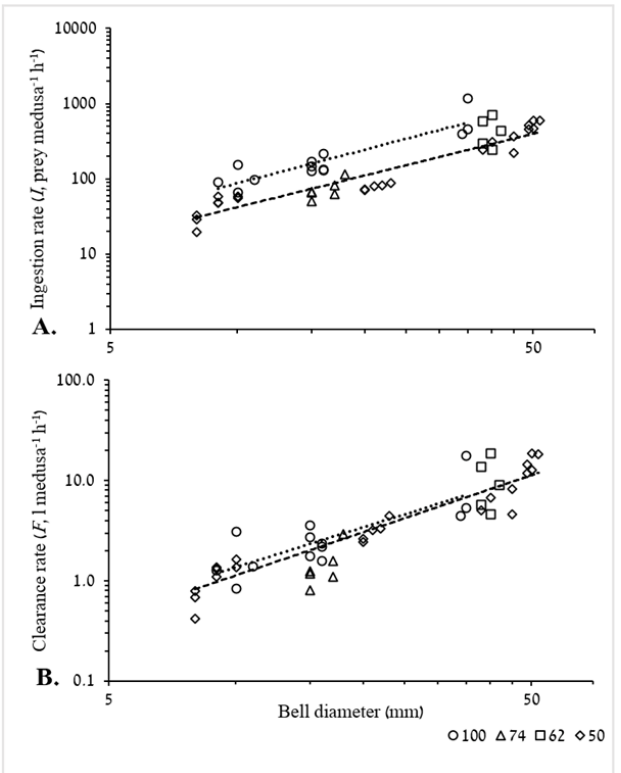
Figure 6. Log–log plot of ingestion rate (I) ( A ) and clearance rate ( B ) as a function of BD at different prey concentrations of 50, 62, 74 and 100 Artemia L −1 ( n = 46). Relatively similar prey concentrations are presented under the same legend values as follows: 50 ( n = 22) = 50 and 53 Artemia L −1 , 100 ( n = 13) = 97, 99 and 100 Artemia L −1 . Dashed curve line for 50 prey L −1 and dotted curve line for 100 prey L −1 . ( A ) I (50 prey L −1 ) = 1.705*BD 1.39 , R 2 = 0.907, F 1, 20 = 194.2, p < 0.001. I (100 prey L −1 ) = 2.924*BD 1.48 , R 2 = 0.813, F 1, 11 = 47.8, p < 0.001. ( B ) F (50 prey L −1 ) = 0.043*BD 1.43 , R 2 = 0.913, F 1, 20 = 204, p < 0.001. F (100 prey L −1 ) = 0.066*BD 1.32 , R 2 = 0.649, F 1, 11 = 20, p < 0.05.